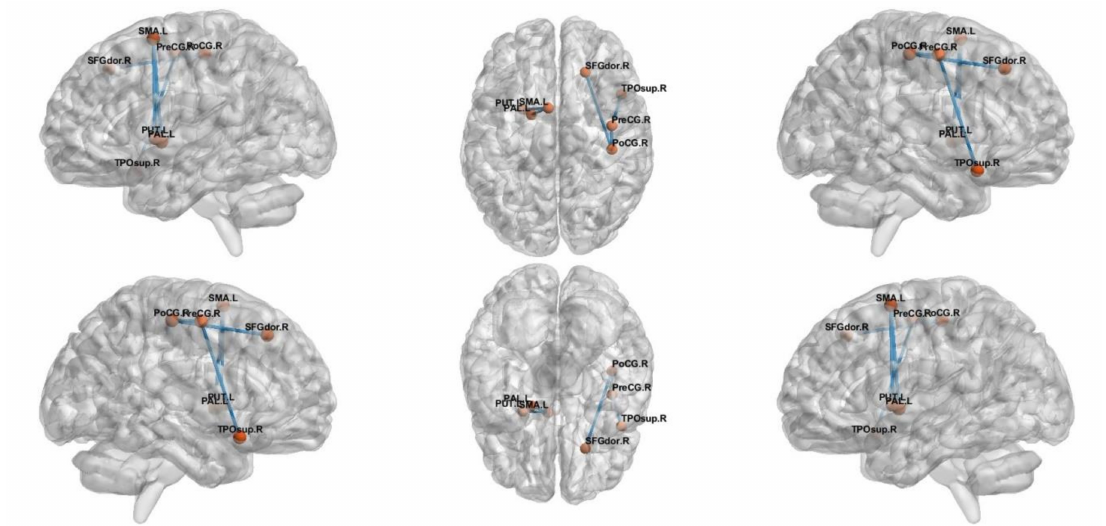
Figure 4. The subnetwork derived from the NBS analysis showing uniformly significantly decreased connections in the MCI subjects compared to the HC.